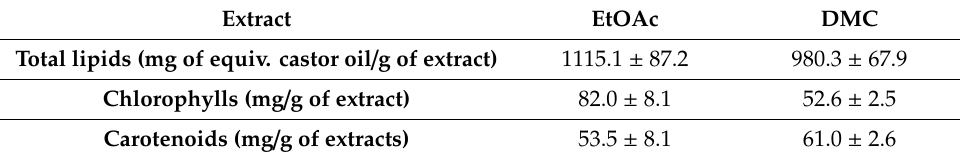
Table 1. A. platensis extracts composition (total lipids, chlorophylls, carotenoids). Extract Total lipids (mg of equiv. castor oil / g of extract)